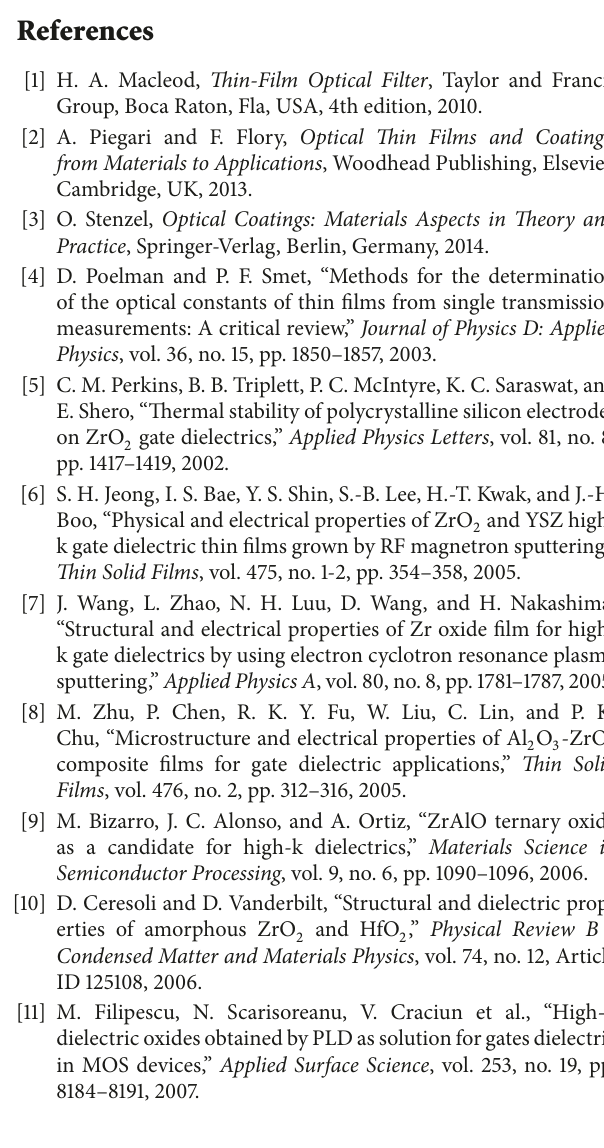
respective transmittance spectrum. In addition, the